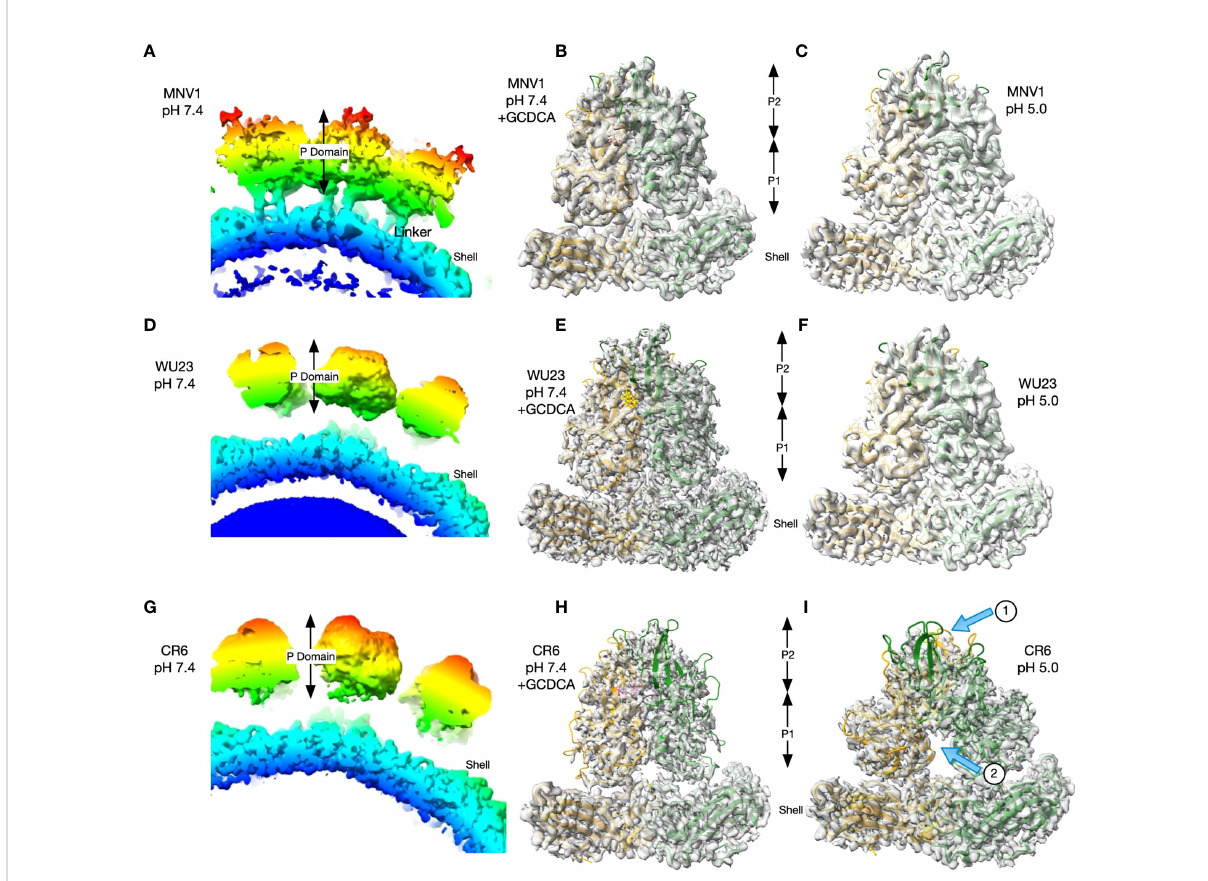
FIGURE 6 While GCDCA causes comparable contraction of virulent and attenuated MNV strains, low pH causes variable conformational changes. (A, D, G) Sections of the image reconstructions of all three strains at pH 7.4 without bile or metals present. Note that all three have fl oating P domains. The linker between the shell and the P domain is more visible in MNV1 because it is a lower resolution structure where those details are not lost. (B, E, H) Magni fi ed views of the MNV P domains at pH 7.4 in the presence of GCDCA (C, F, I) Representative images of a magni fi ed view of the MNV P domains at pH 5.0. In the bottom CR6 image, arrow 1 indicates the weak density of the P domains and arrow 2 indicates the splaying of P1 domains at the base that is not observed for MNV1 or